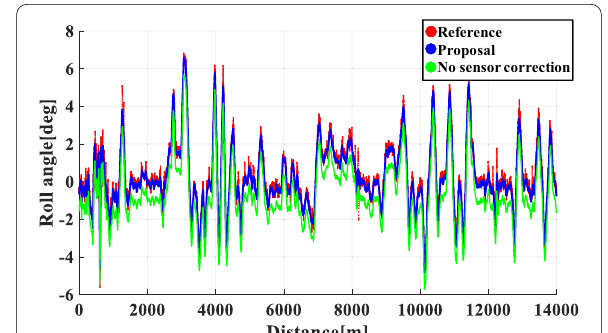
Fig. 11 Estimated roll angle (Urban highway)